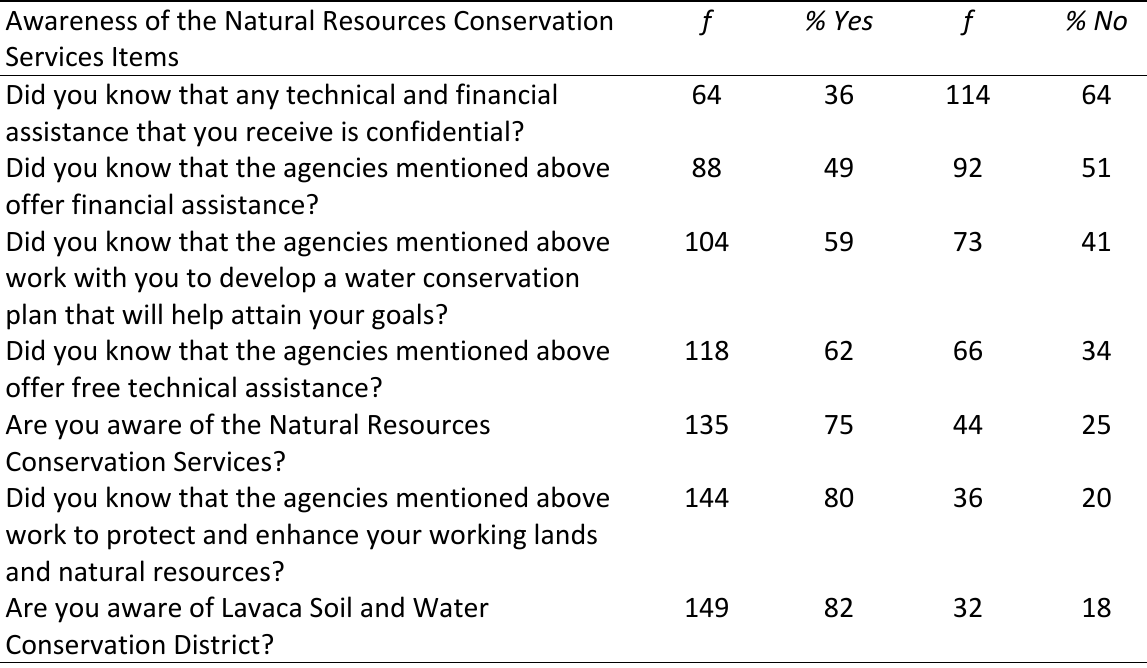
Descriptive Statistics for Awareness of the Natural Resources Conservation Service & Texas State Soil and Water Conservation